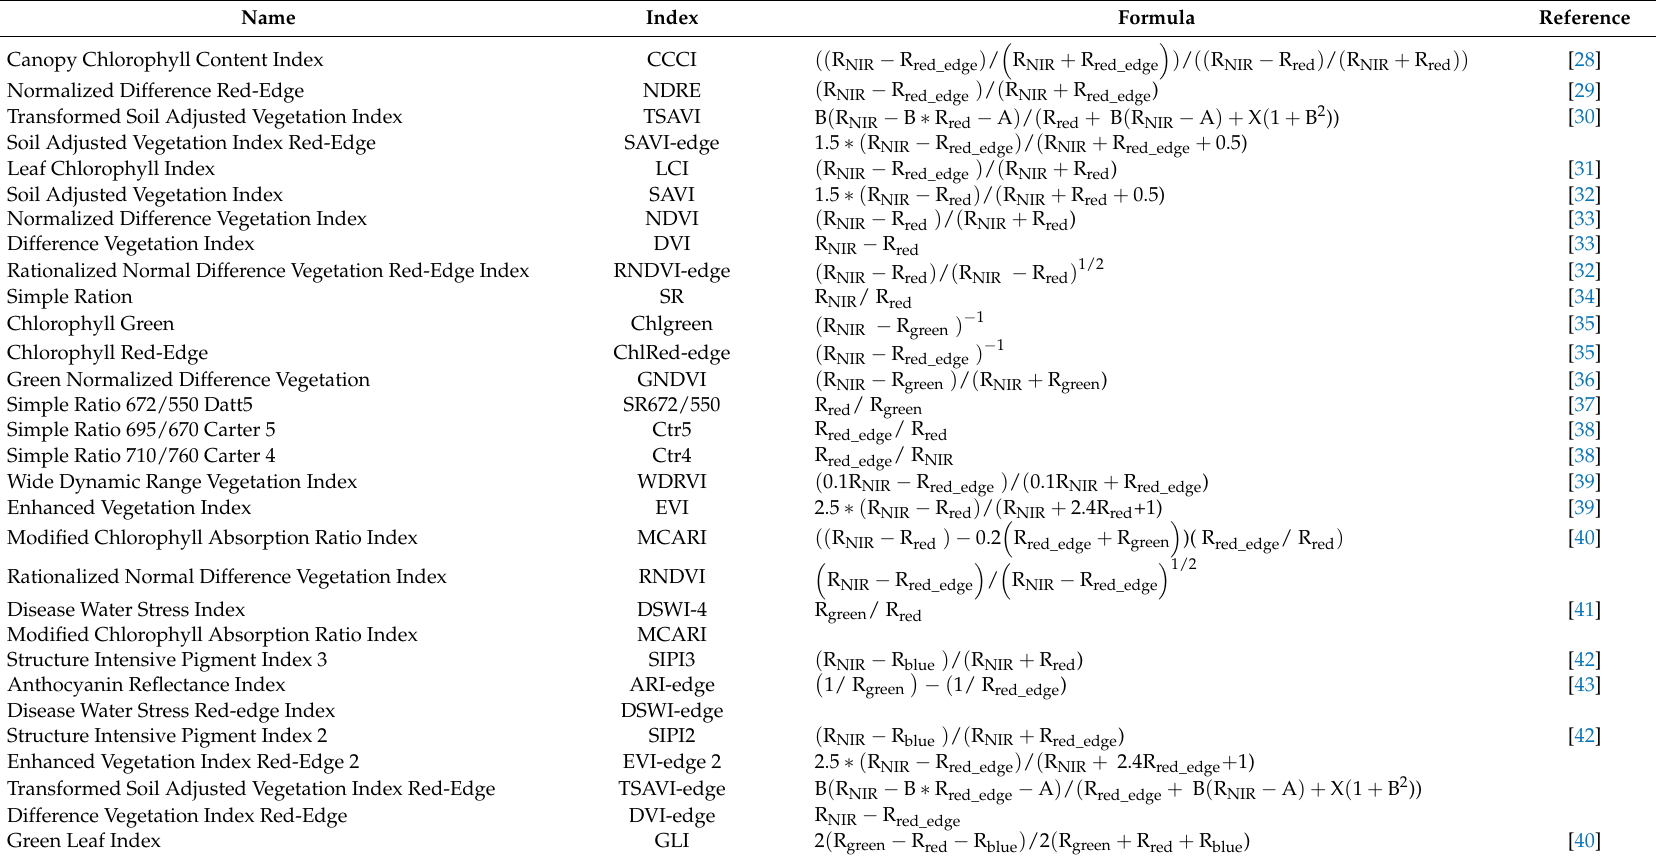
Table 1. Spectral vegetation indices used in the study. Source information is given in the last